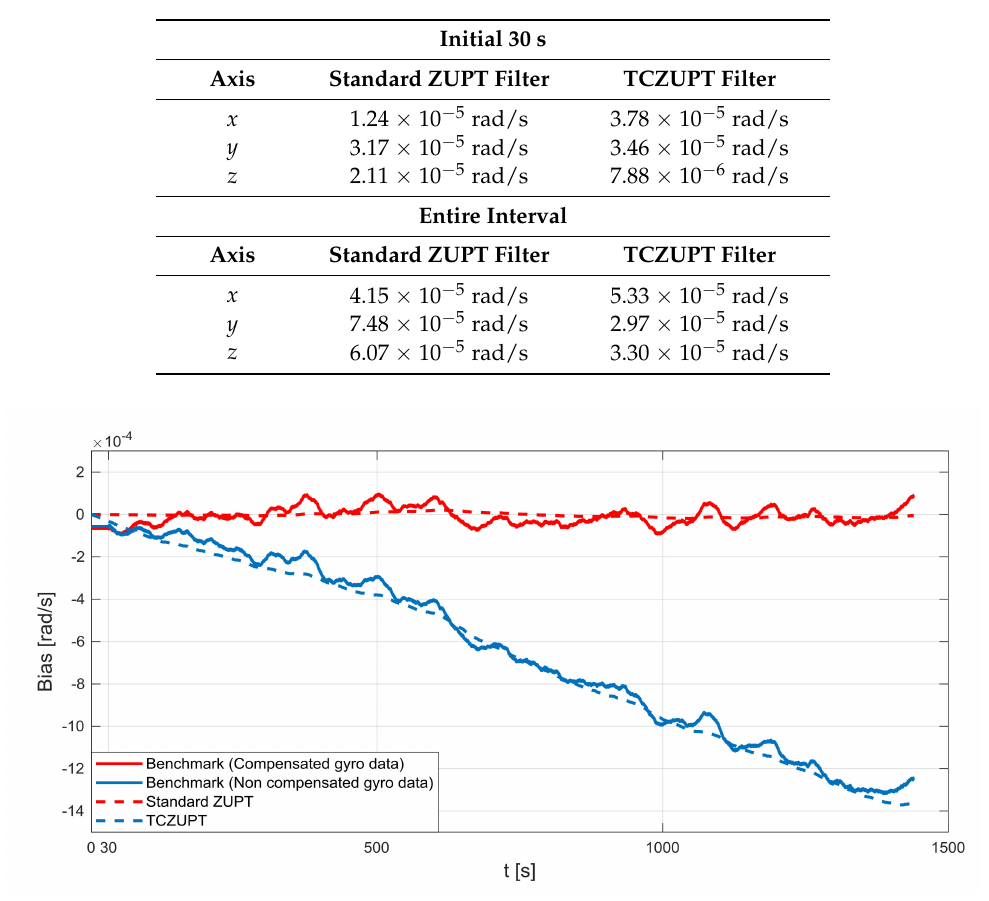
Figure 14. Gyro output bias (residual error of 15 degree/h, x -axis).